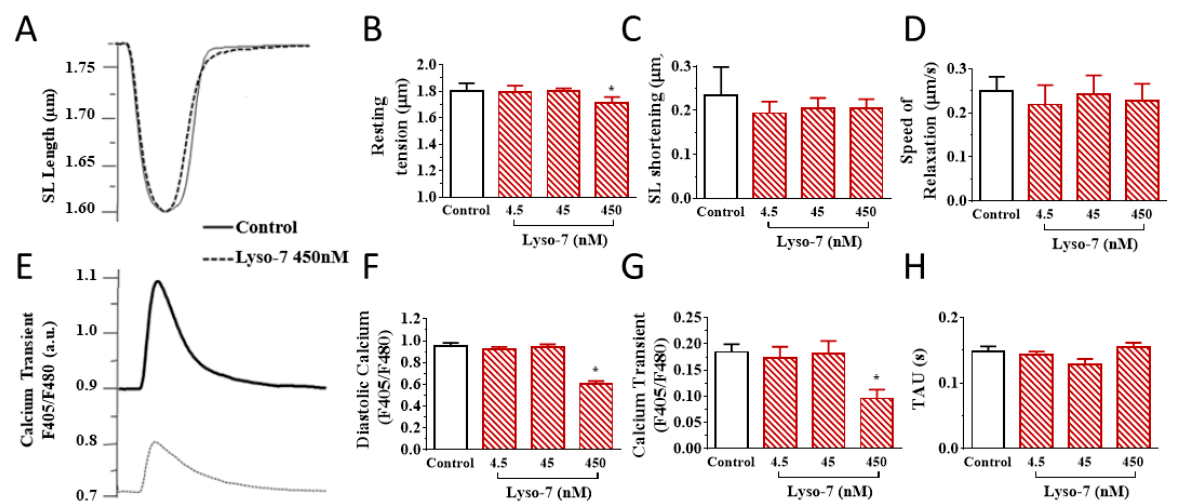
Figure 6. Acute in vitro effect of Lyso-7 on contraction ( A – D ) and Ca 2+ transient ( E – H ) of cardiomyocytes under IsoproTable 10. nM). Typical recordings of Lyso-7 (450 nM) effects on ( A ) sarcomere length (SL) shortening and ( E ) Ca 2+ transient, both under field stimulation at 1 Hz. ( B – D ) averaged data of resting SL, SL shortening and relaxation, respectively, and ( F – H ) averaged data of diastolic Ca 2+ , Ca 2+ transient and decay of Ca 2+ transient (Tau), respectively, for Control, and increasing concentration of Lyso-7 (4.5, 45, and 450 nM). ANOVA followed by Tukey post-test ( p < 0.05). * Lyso-7 vs. Control. Control refers to the absence of Lyso-7. n =